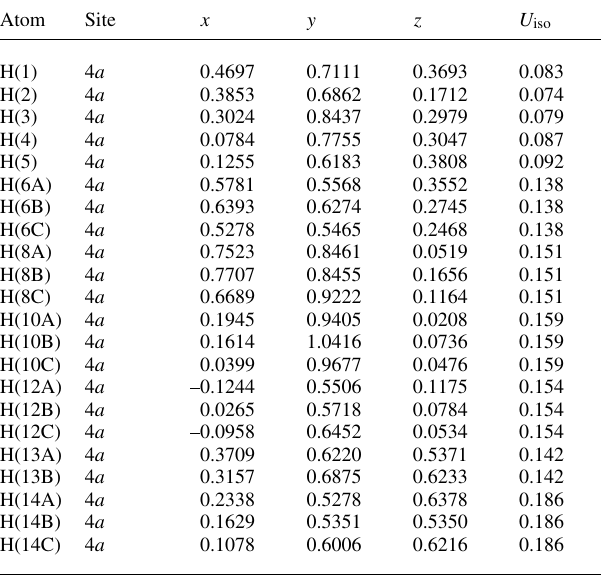
Table 2. Atomic coordinates and displacement parameters (in Å 2 )